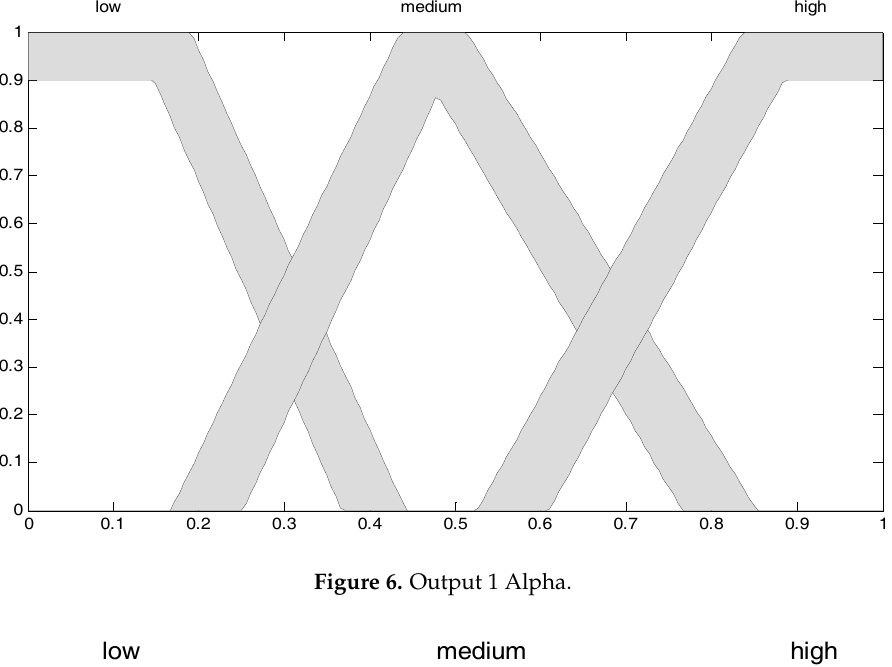
Figure 6. Output 1 Alpha.